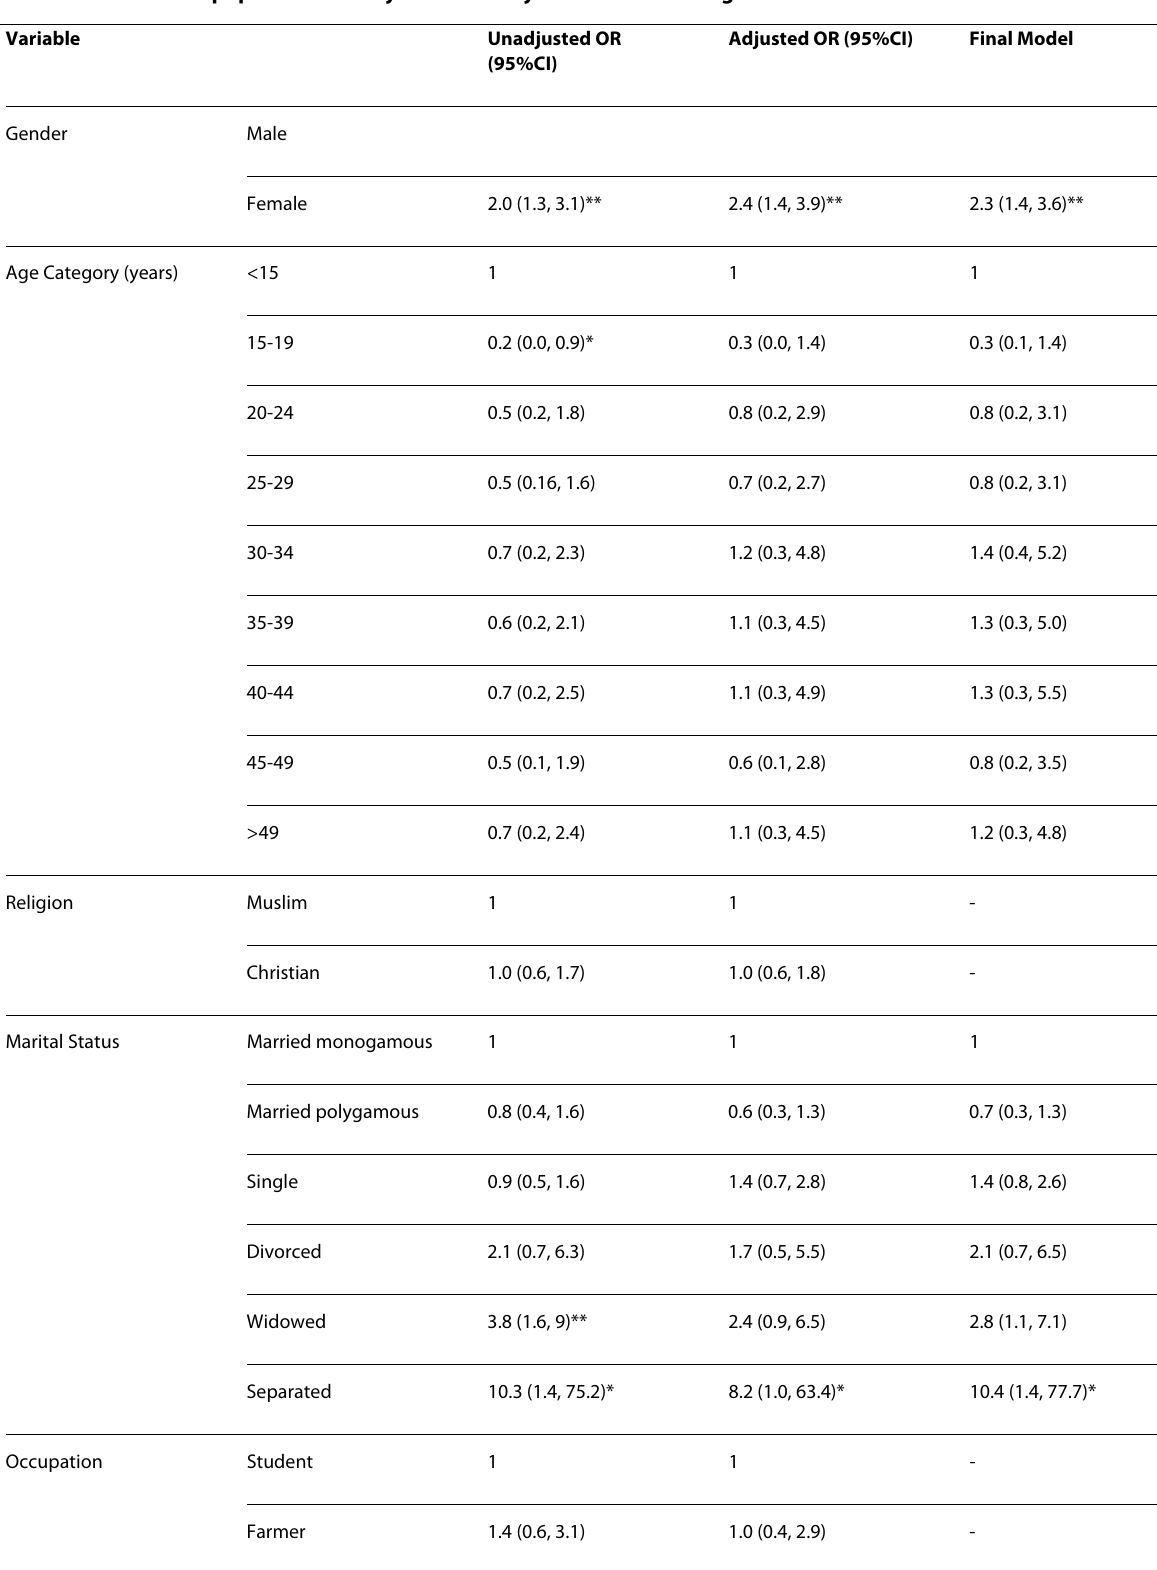
Table 3: Non-antenatal population: Unadjusted and Adjusted ORs of Testing Positive